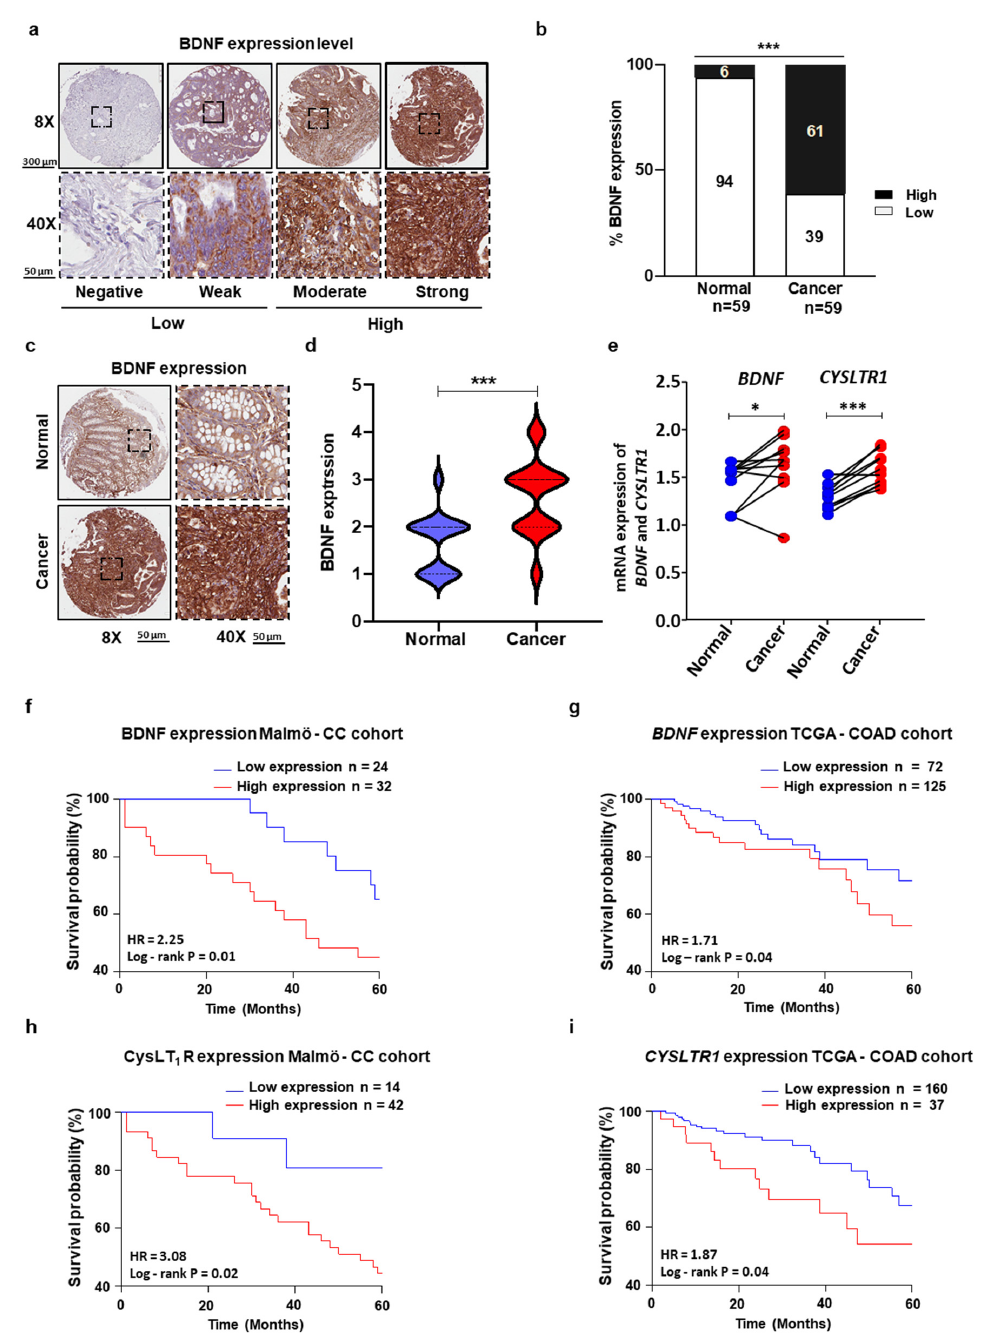
Figure 4. Expression levels of BDNF in patient colon cancer (CC) tissues negatively correlated with CC patient survival. ( a ) Representative BDNF IHC staining of the CRC patient cohort with negative, weak, moderate, and strong BDNF expression levels, n = 59; 8× (scale bars, 300 µm) and 40× (scale bars, 50 µm) magnification. ( b ) Percentage of patient tissues with low (negative, weak) and high (moderate, strong) BDNF expression. ( c ) Representative BDNF IHC staining of normal colon tissue (upper images) and matched colon tumor tissues (lower images). ( d ) IHC scoring of the level of BDNF intensity shown by the violin plot from normal areas and the matched tumor area. ( e ) qPCR analysis showing the expression of BDNF and CYSLTR1 in matched paired normal mucosa and cancer tissue samples from 10 CRC patients. ( f , g ) Kaplan–Meier survival curves in Malmö CC cohort ( f ) and TCGA-COAD cohort ( g ) according to the expression status of BDNF using the log-rank test. ( h , i ) Kaplan–Meier survival curves in Malmö CC cohort ( h ) and TCGA-COAD cohort ( i ) according to the expression status of CysLT 1 R using the log-rank test. The results are shown as the mean ± standard error of the mean (SEM), paired t -test ( d ) and chi-square test ( b ). Scale bars as indicated in the images. * p < 0.05, *** p <